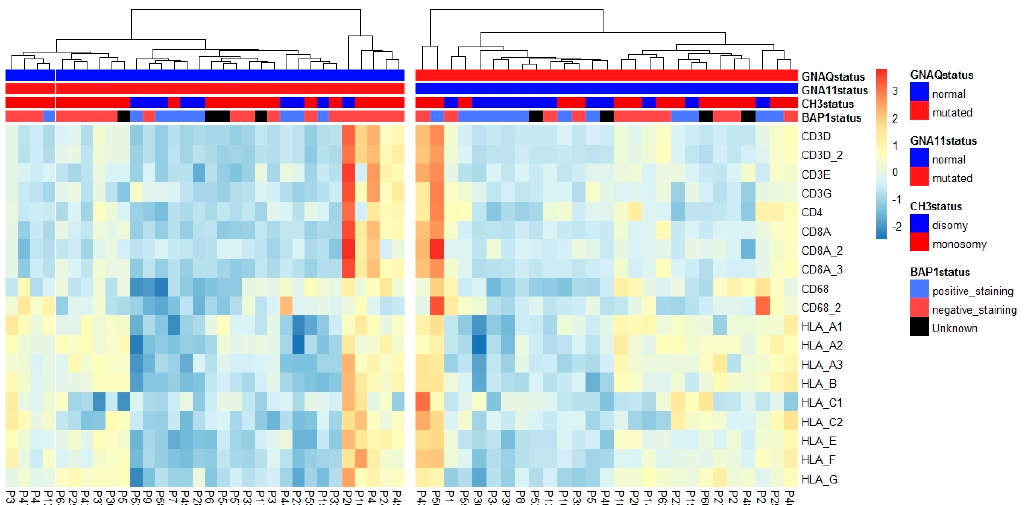
Figure 4. Heatmap of tumors split according to GNAQ / GNA11 mutation. The heatmap shows the expression of several infiltrate and HLA Class I markers, normalized per marker over all 59 tumors. Annotated is the chromosome 3 status (blue for D3 tumors, red for M3 tumors). BAP1 staining is annotated below the chromosome 3 status. Positive staining for BAP1 is blue (BAP1 is normal), red is given for absent staining and black is given for unknown BAP1 status. Mutations on GNAQ / GNA11 only include Q209L and Q209P mutations. GNAQ mutated: n = 27, GNA11 mutated: n = 32.